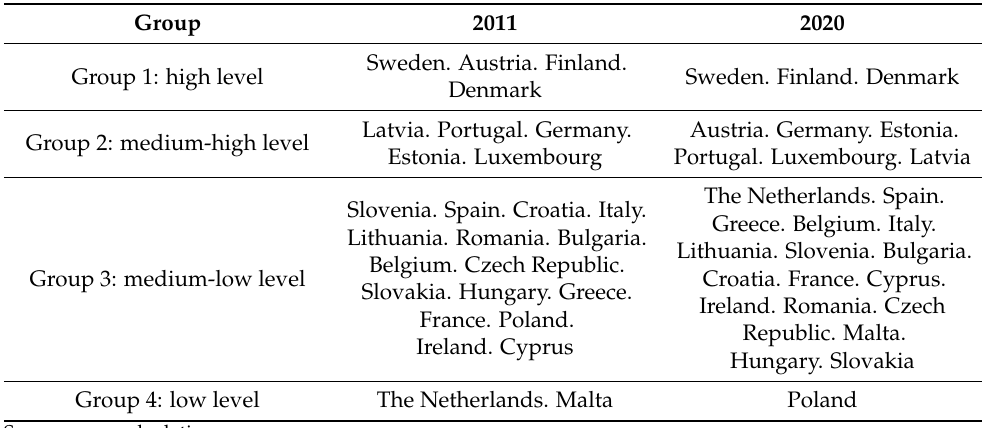
Table 6. Classification of EU countries in terms of the use of renewable energy in 2011 and 2020. Group